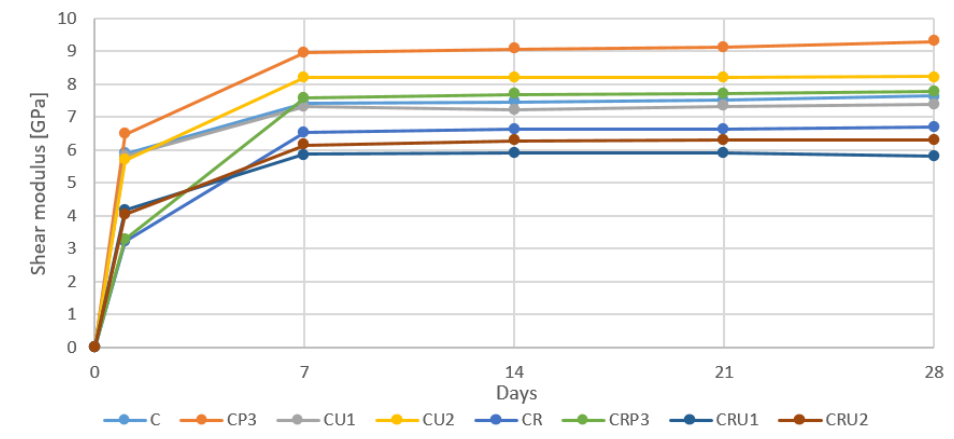
Figure 3. Increase the dynamic shear modulus over